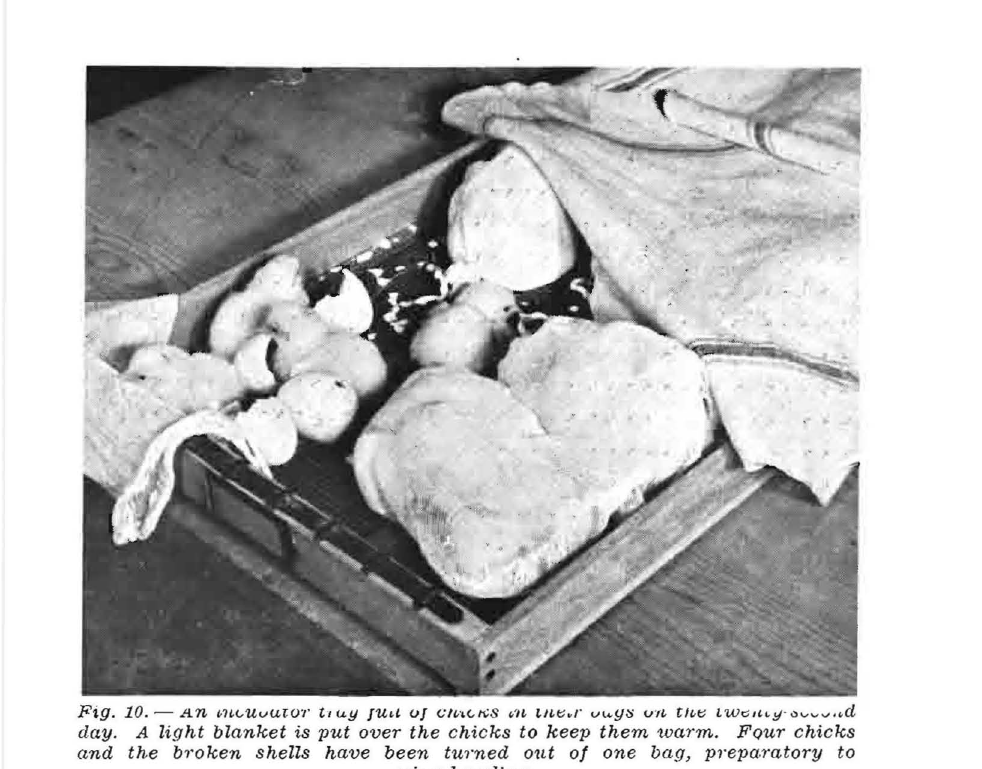
Fig. 10. - An t.?u ... U vuto'l' hug JU .. L uJ (;/"\~"'S "'It l,Ju;: .. r Vl4.y:s V'll, t/(,t: tW~I, ... y·" ................. d day, A light blanket is put over the chicks to keep them warm, Four chicks and the b,'oken shells have been tu,'ned out of one bag, p,'eparatory to